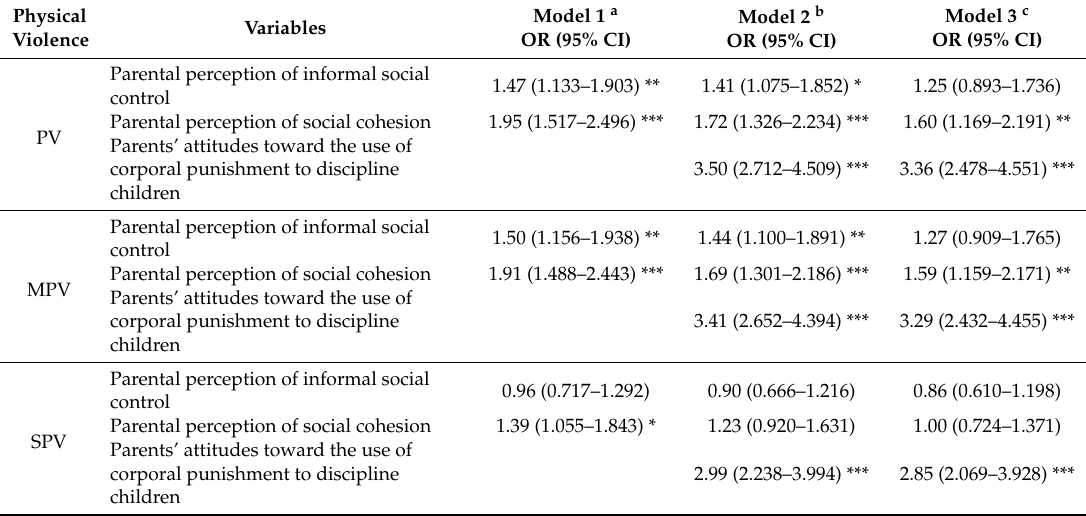
Table 4. Multivariate logistic regression models with di ff erent severity level of PV as